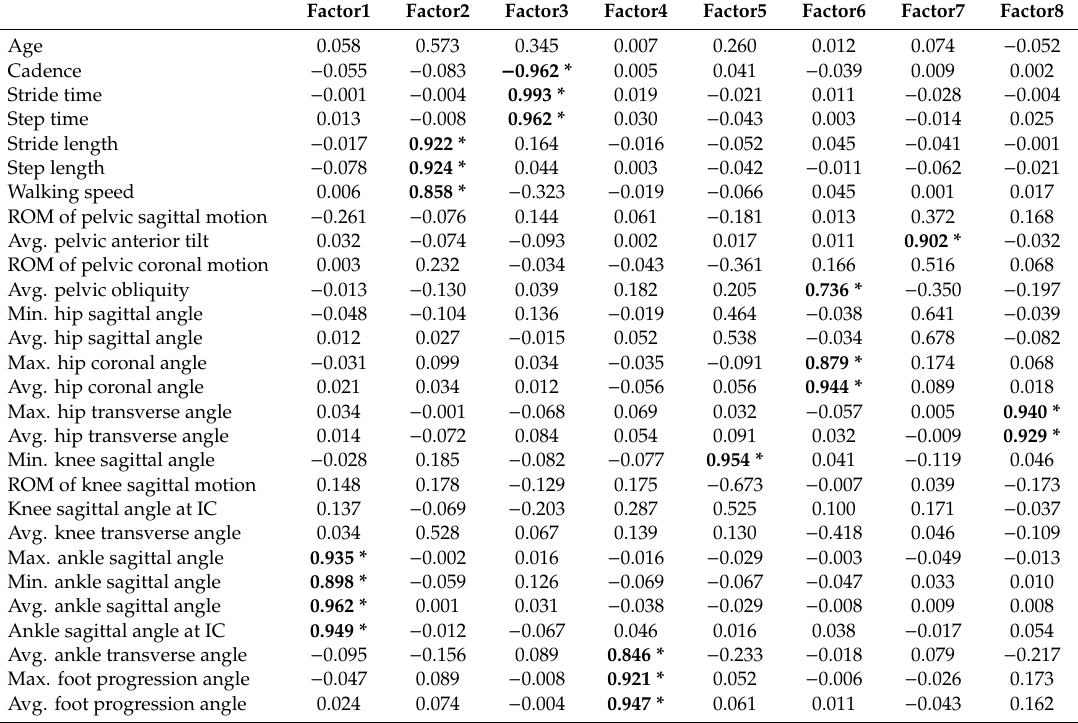
Table 5. Gait factors classified by clustering